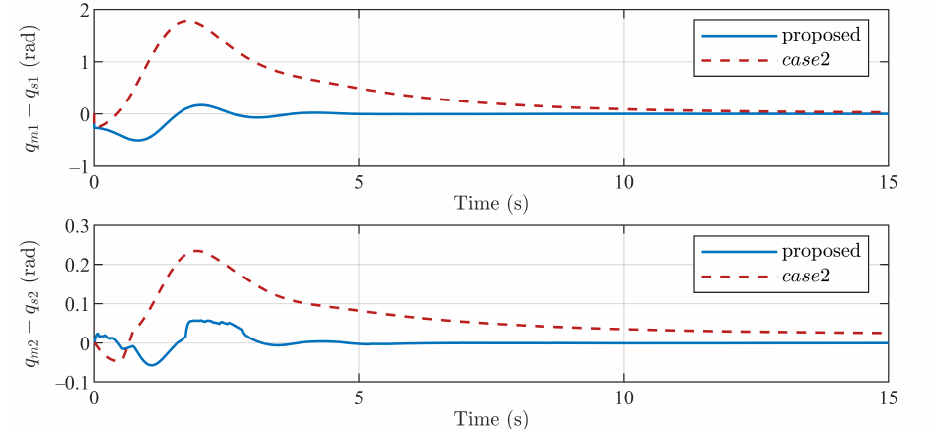
Figure 14. Task performances of the master and slave robots with the method in Case 2.